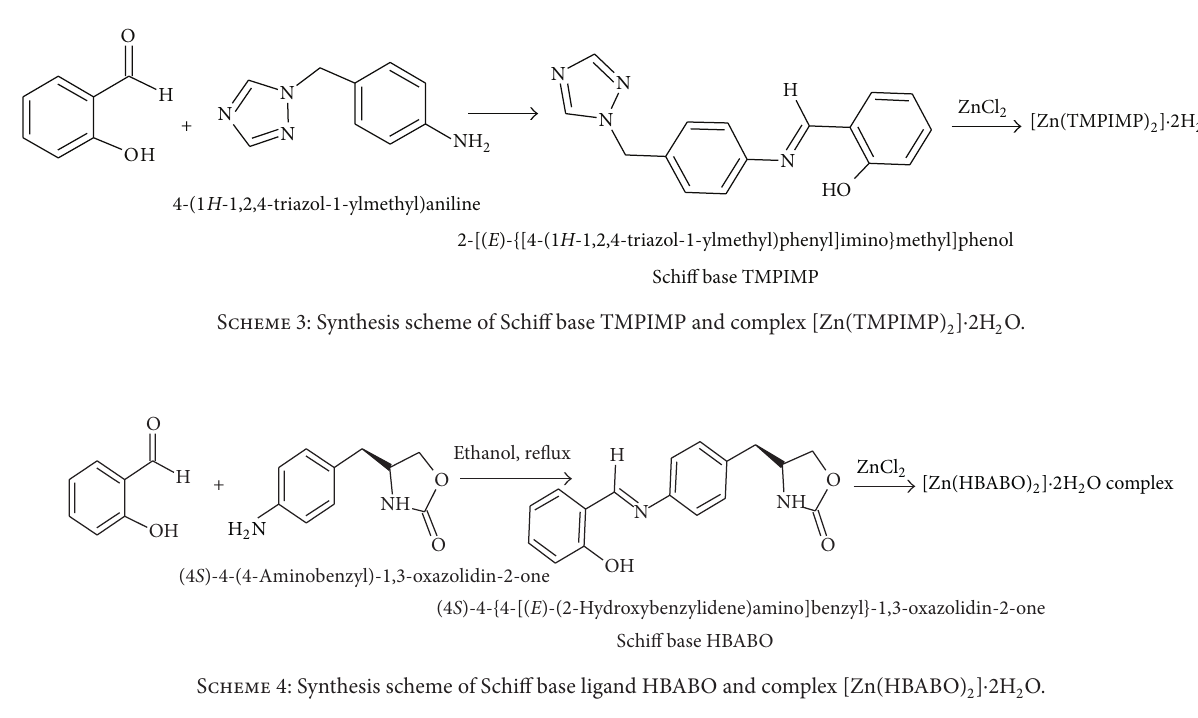
Scheme 4: Synthesis scheme of Schiff base ligand HBABO and complex [Zn(HBABO) 2 ] ⋅ 2H 2 O.